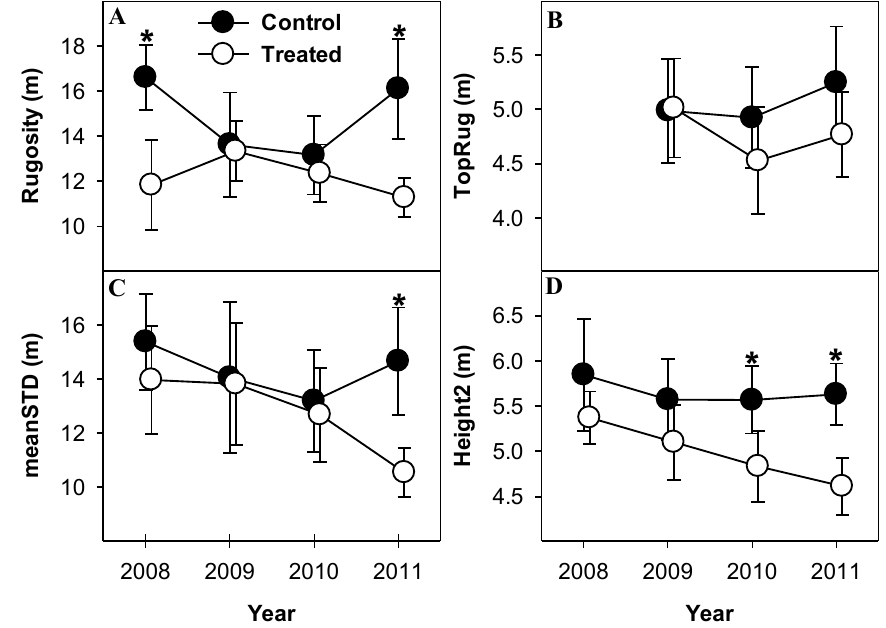
Figure 6. Canopy heterogeneity following girdling as indicated by canopy structural complexity (rugosity) ( A ), variability of outer canopy surface height (TopRug) ( B ), mean variability of leaf height (meanSTD) ( C ), and variability of mean leaf height (height2) ( D ). Treated canopies became less structurally heterogeneous according to all metrics except TopRug. Values are means of paired treated and control plots with standard error bars representing between-plot variation. * indicate significant differences between treated and control plot